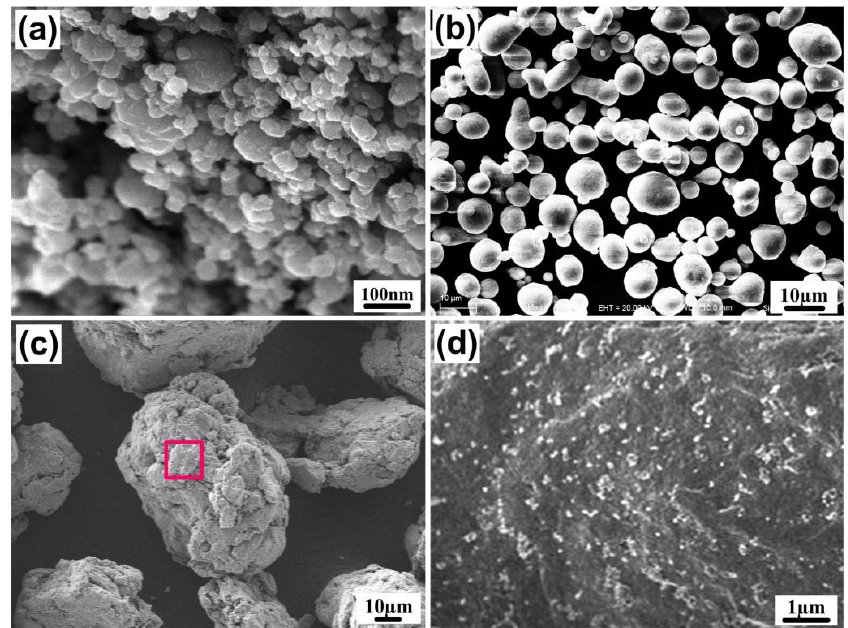
Figure 1. SEM images of morphologies of the raw ( a ) nano-sized SiC particles and ( b ) Al–Cu alloy powders; FESEM (field emission SEM) images of ( c ) nano-sized SiC p /Al–Cu composite powders after ball milling; ( d ) high magnification of the area marked in ( c ).